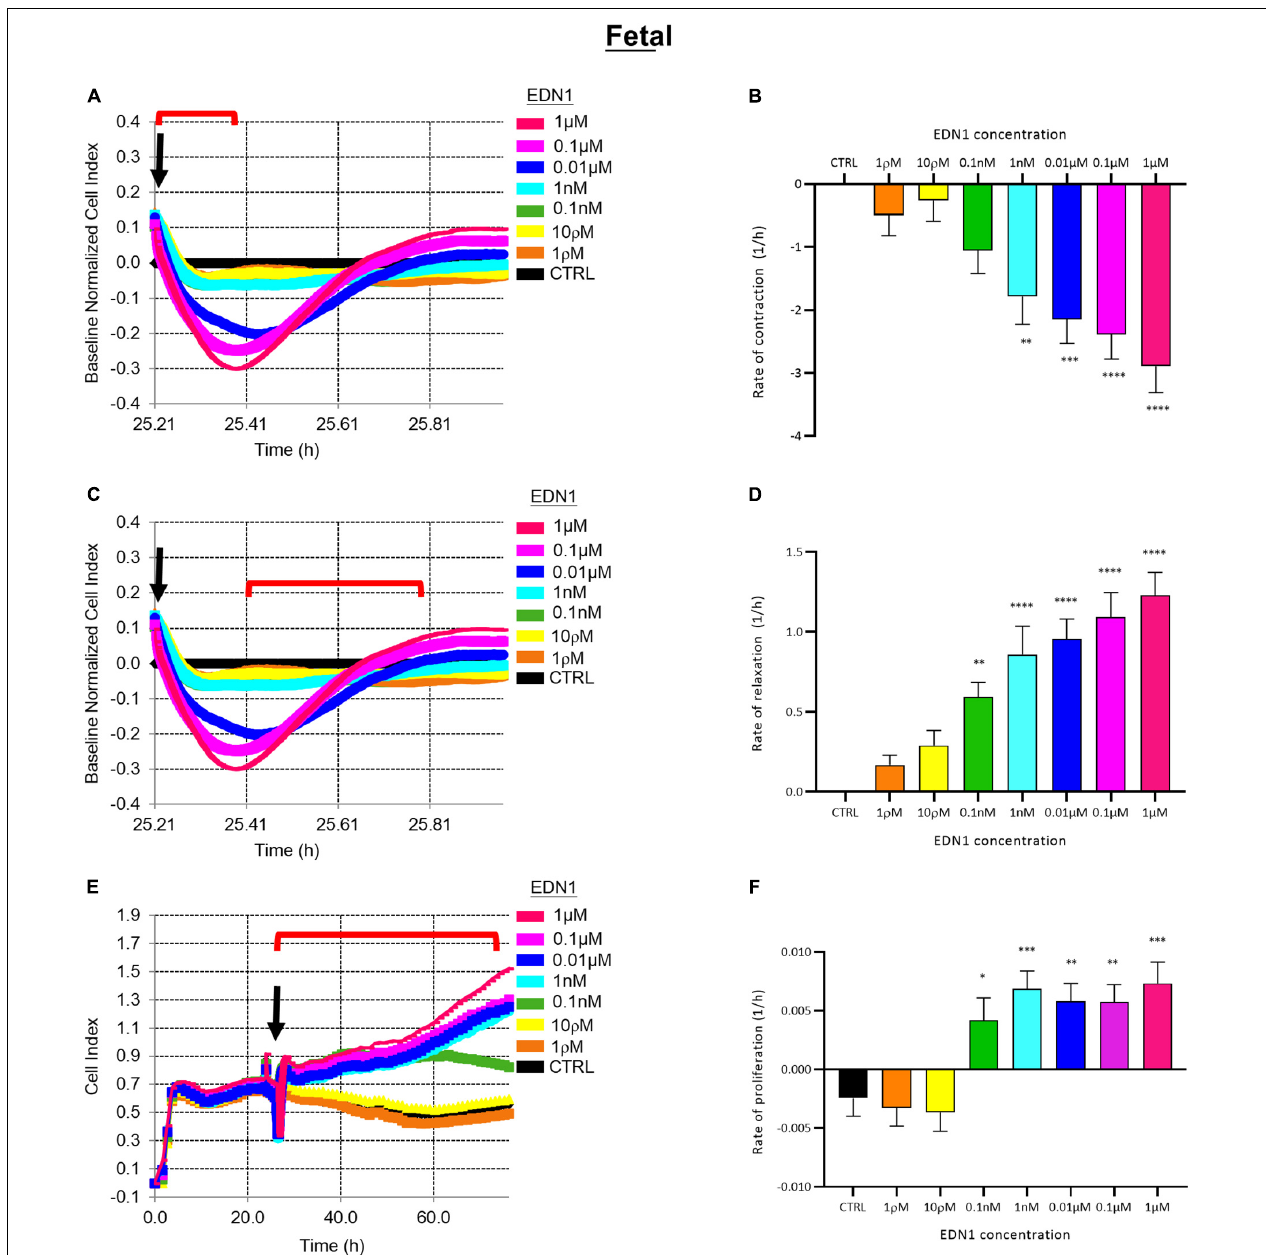
FIGURE 2 | (A) Representative electrical impedance measurements of the contractile response of fetal human brain vascular pericytes (fHBVP) to EDN1. (B) The rate of contraction was significantly increased by addition of 1 nM ( p = 0.0039, Dunnett’s test), 0.01 µ M ( p = 0.0003), 0.1 µ M ( p < 0.0001) or 1 µ M ( p < 0.0001) EDN1 ( n = 12). (C) Representative electrical impedance measurements of the relaxation response of fHBVP following contraction. (D) The increased rate of contraction was followed by more rapid relaxation in cells treated with 0.1 nM ( p = 0.0085), 1 nM ( p < 0.0001), 0.01 µ M ( p < 0.0001), 0.1 µ M ( p < 0.0001) or 1 µ M ( p < 0.0001) ( n = 12). (E) Representative electrical impedance measurements of the proliferative response of the fHBVP after EDN1. (F) Proliferation was significantly increased after the addition of 0.1 nM ( p = 0.0290), 1 nM ( p = 0.0008), 0.01 µ M ( p = 0.0038), 0.1 µ M ( p = 0.0041), or 1 µ M ( p = 0.0004) EDN1 ( n = 12). The bars represent the mean values and SEM. Arrows indicate time of EDN1 addition. The timeframe referred to in each graph is indicated by the red